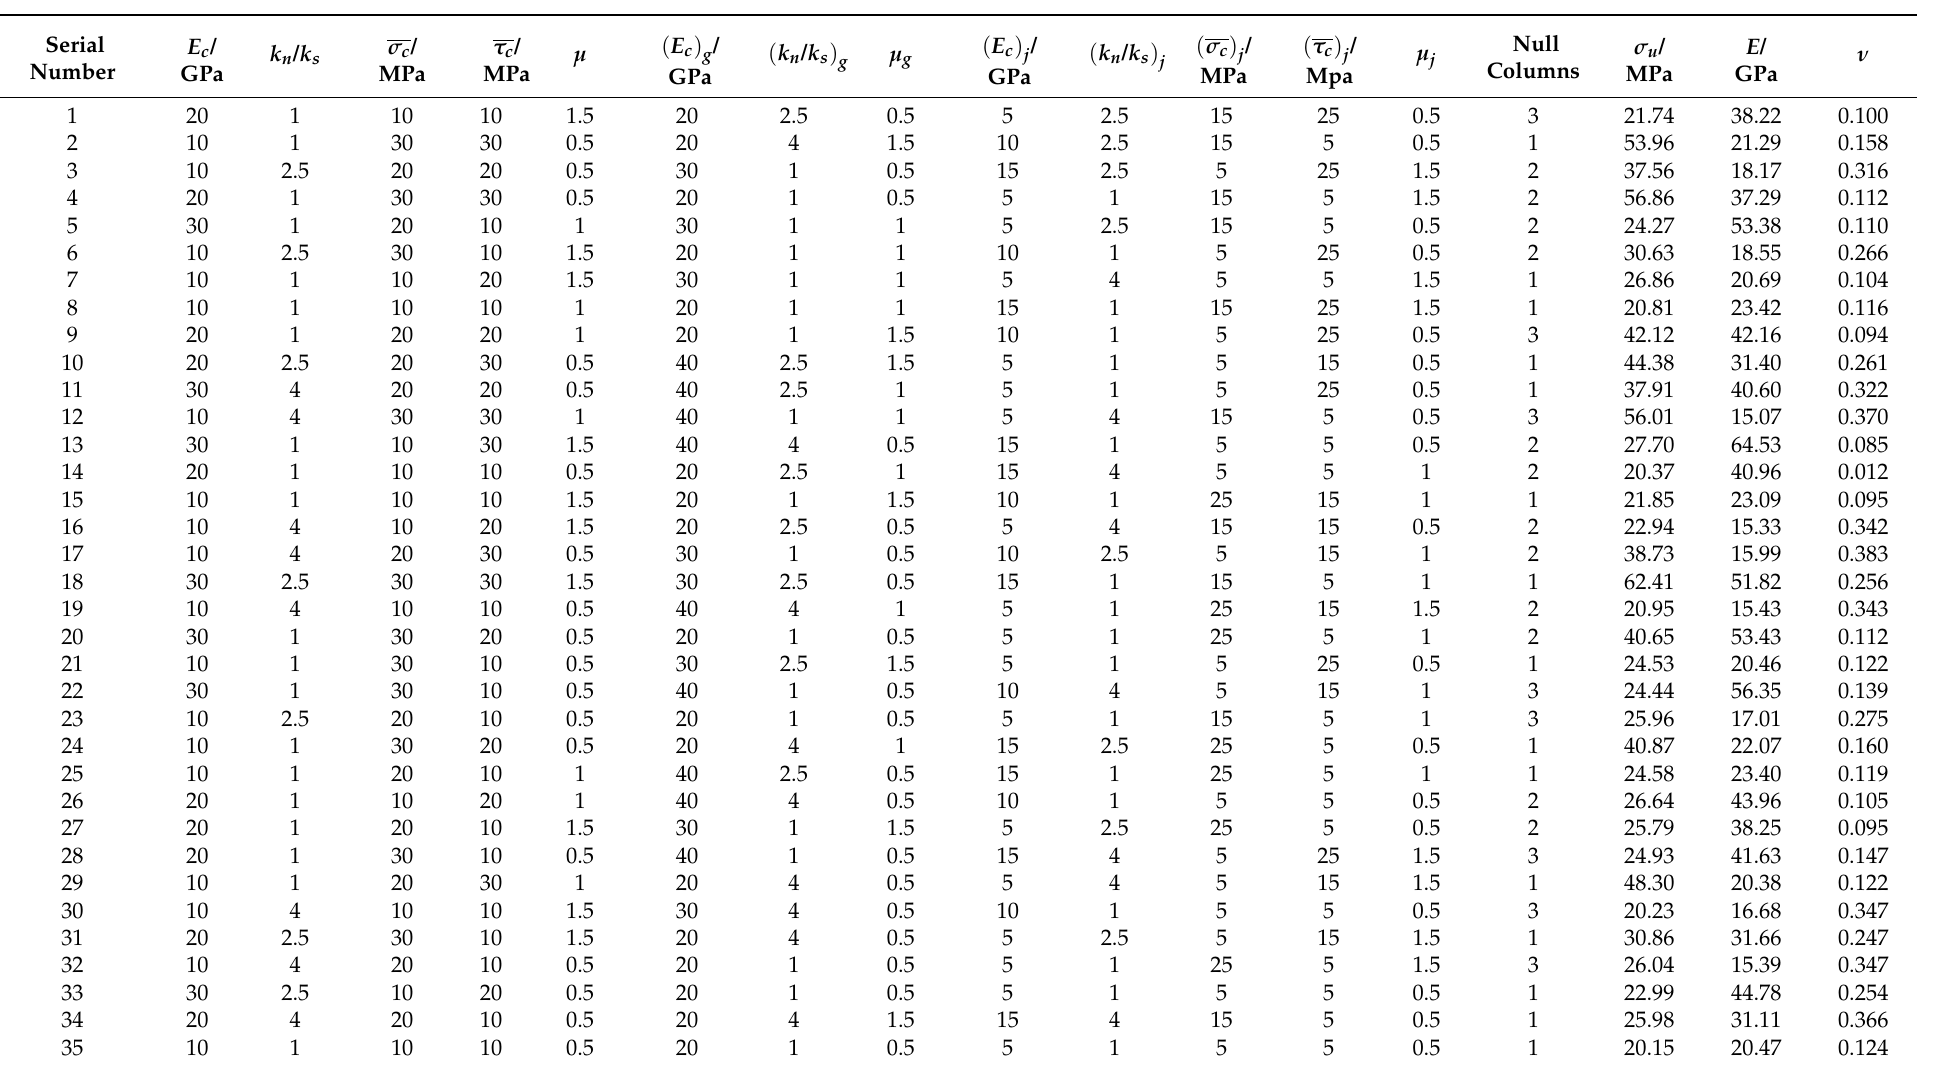
Table 6. Orthogonal test scheme and